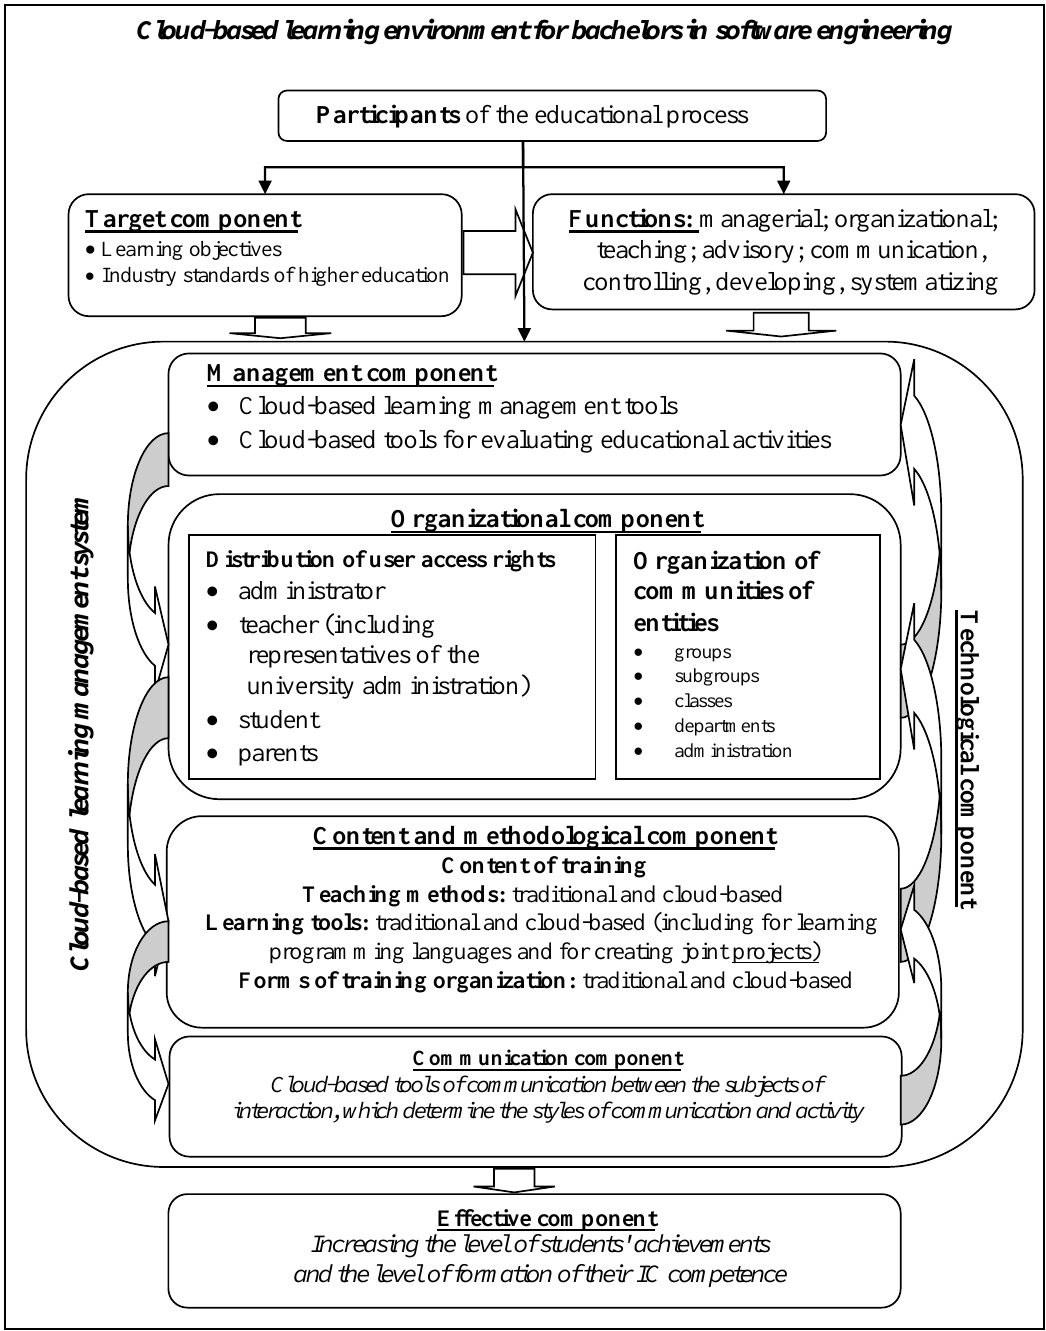
Fig. 1. Structural model of COLE training of bachelor in software engineering Figure 1: Structural model of a cloud-based learning environment for bachelors in software engineering.